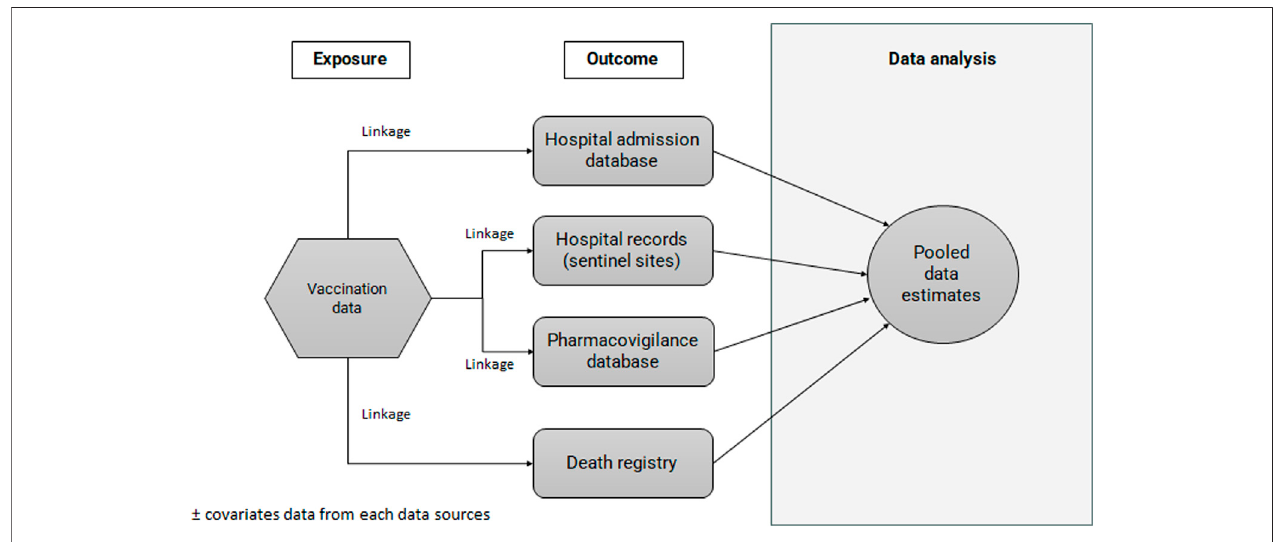
FIGURE 1 | Linkage of data sources for establishment of study cohort.